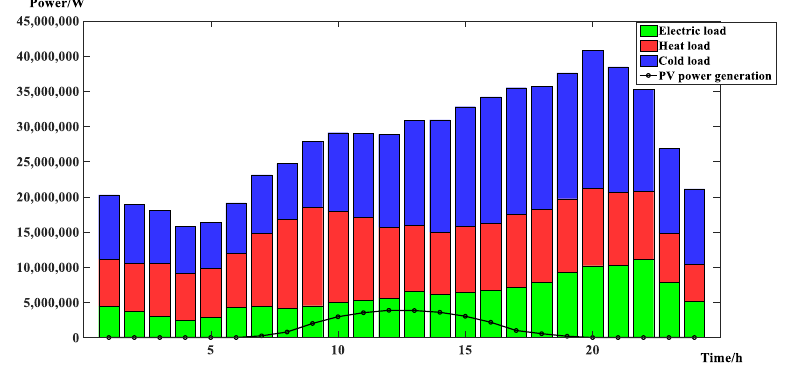
Figure 5. Load and photovoltaic power generation of the park.